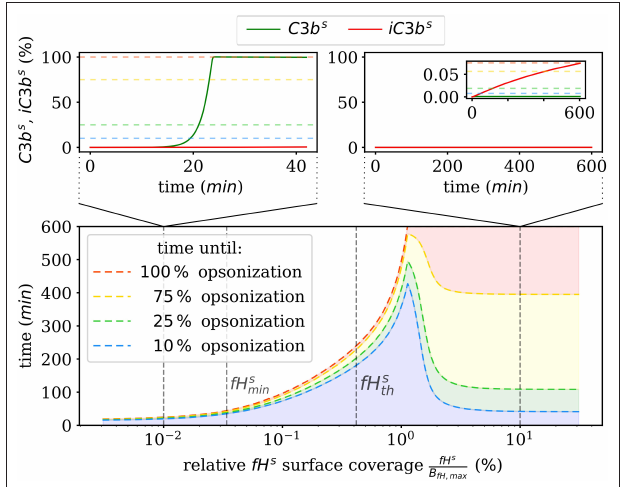
FIGURE 4 | Proportion of C 3 b molecules at the cell surface. Based on the dominating types of C 3 b molecules, we distinguish the two extreme regimes for non-self recognition and self-tolerance that are separated by a transition regime where complement evasion takes